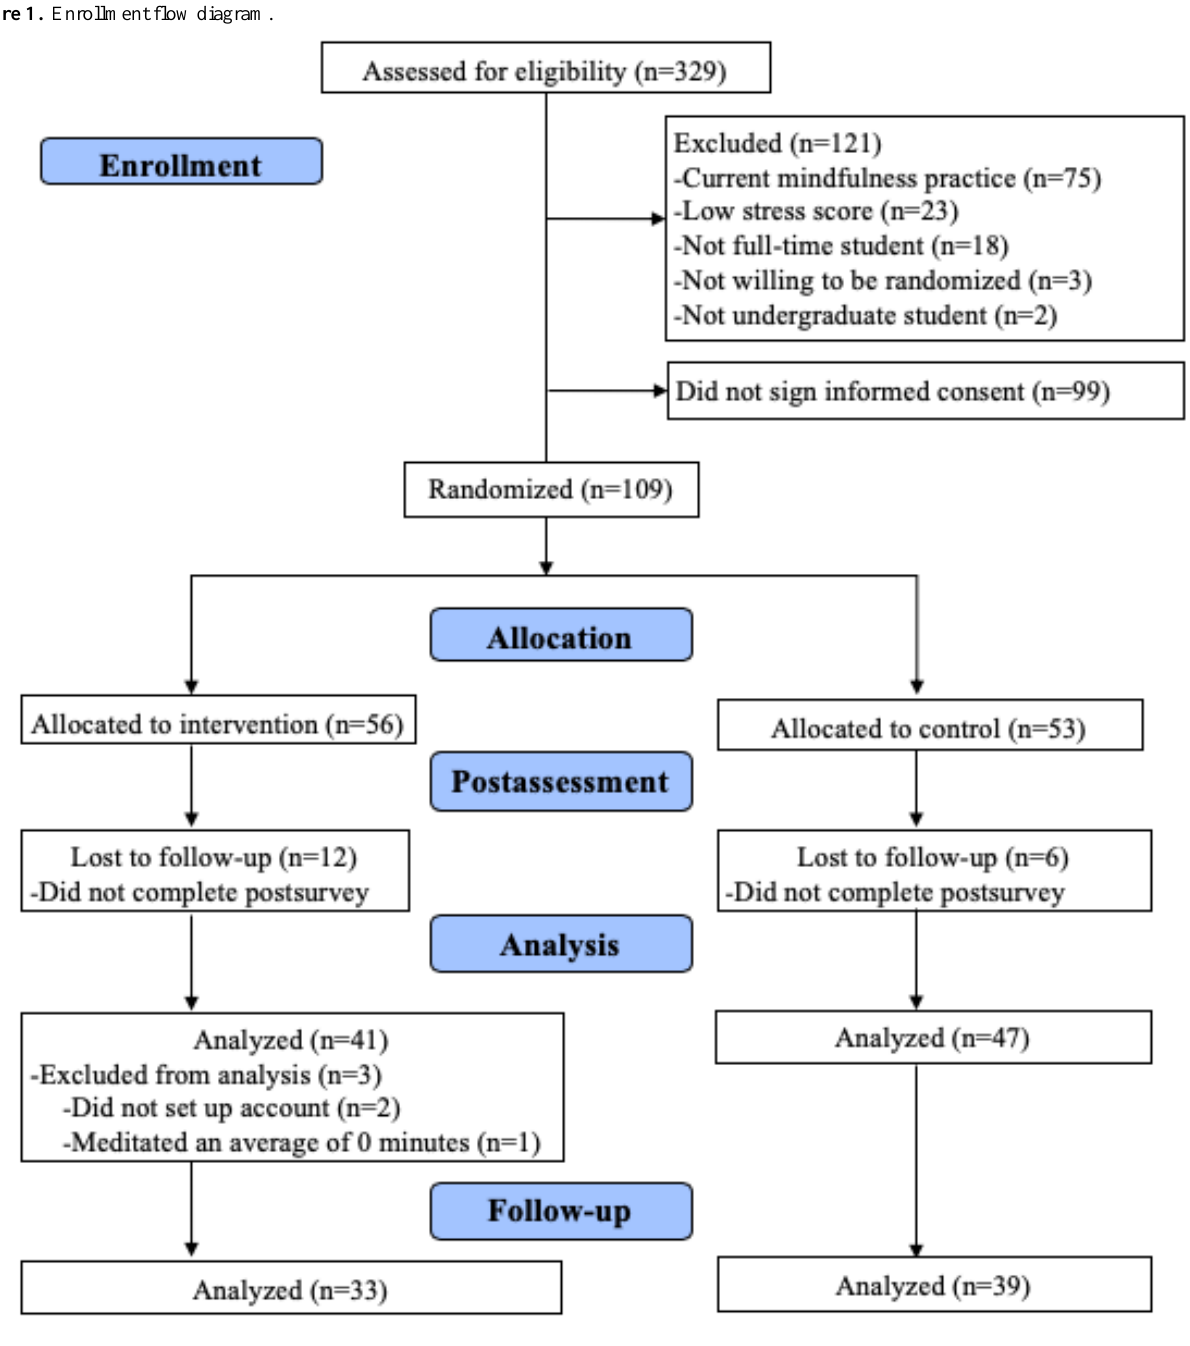
Figure 1. Enrollment flow